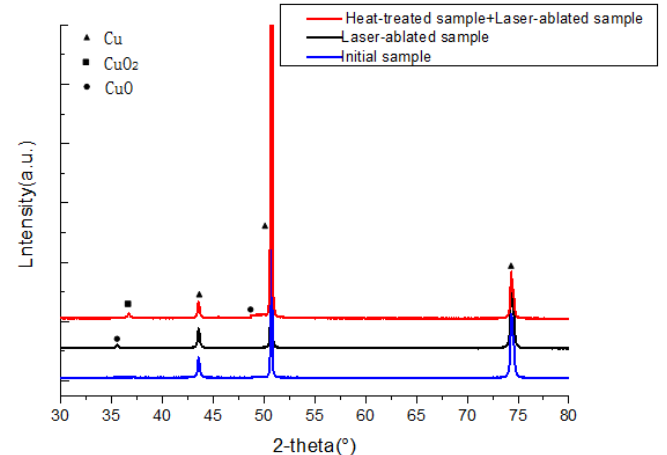
Figure 5. X-ray diffraction (XRD) results for initial sample, laser-ablated sample, and heat-treated Figure 5. X-ray di ff raction (XRD) results for initial sample, laser-ablated sample, and sample. heat-treated sample.